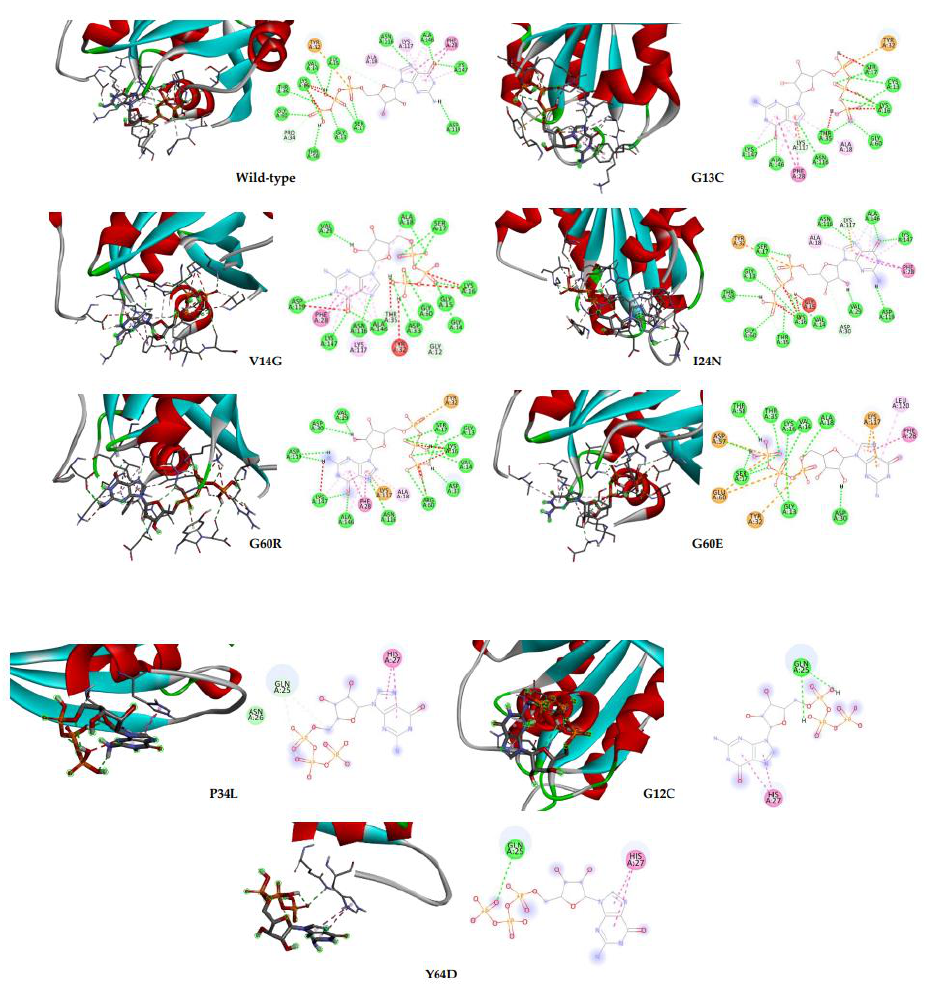
Figure 5. Docking profile of NRAS protein (wild-type and mutated) and GTP. The right panel shows the 2D representation of the interaction with ligands and the receptors in the binding pocket.